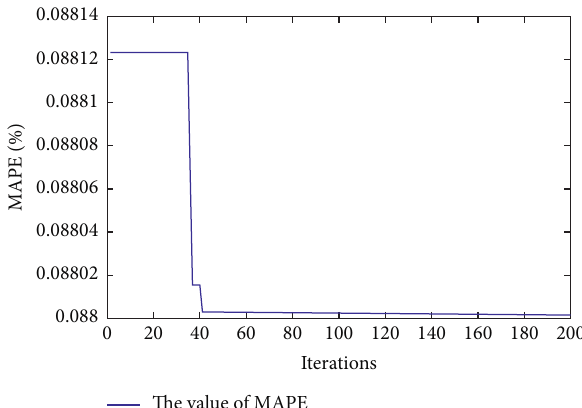
Figure 2: Optimization process of FGM (1, 1) based on PSO algorithm (an example of